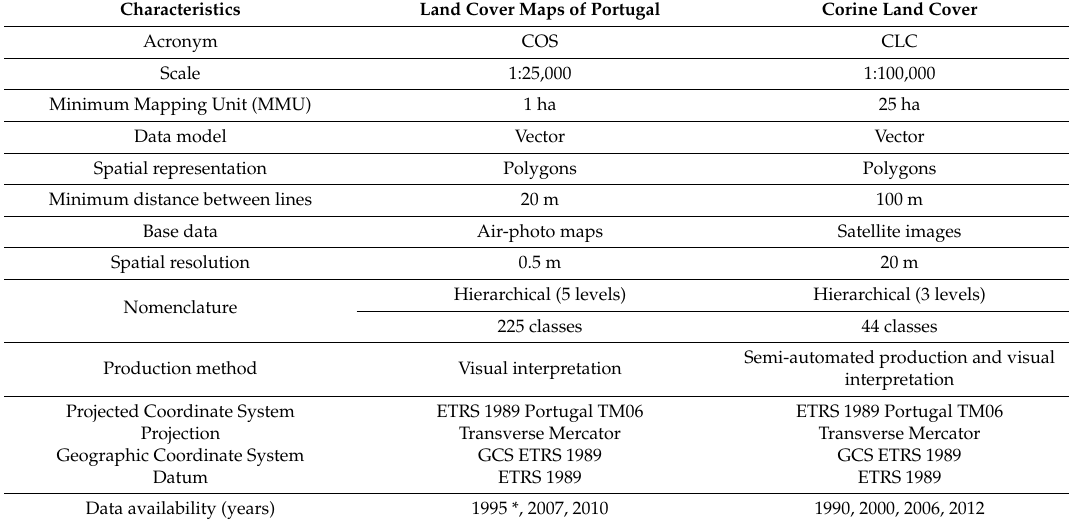
Table 1. Characteristics and properties of LUC geoinformation.